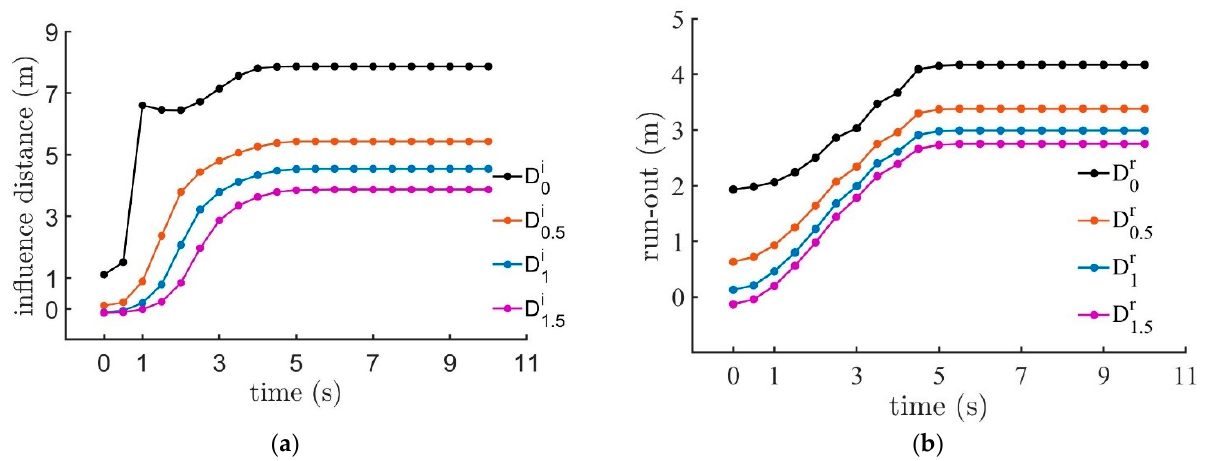
Figure 11. Variation of runout and influence distance with time from CEL simulations: ( a ) distance of the slope top with time (influence distance); ( b ) distance of the slope toe with time (runout distance).